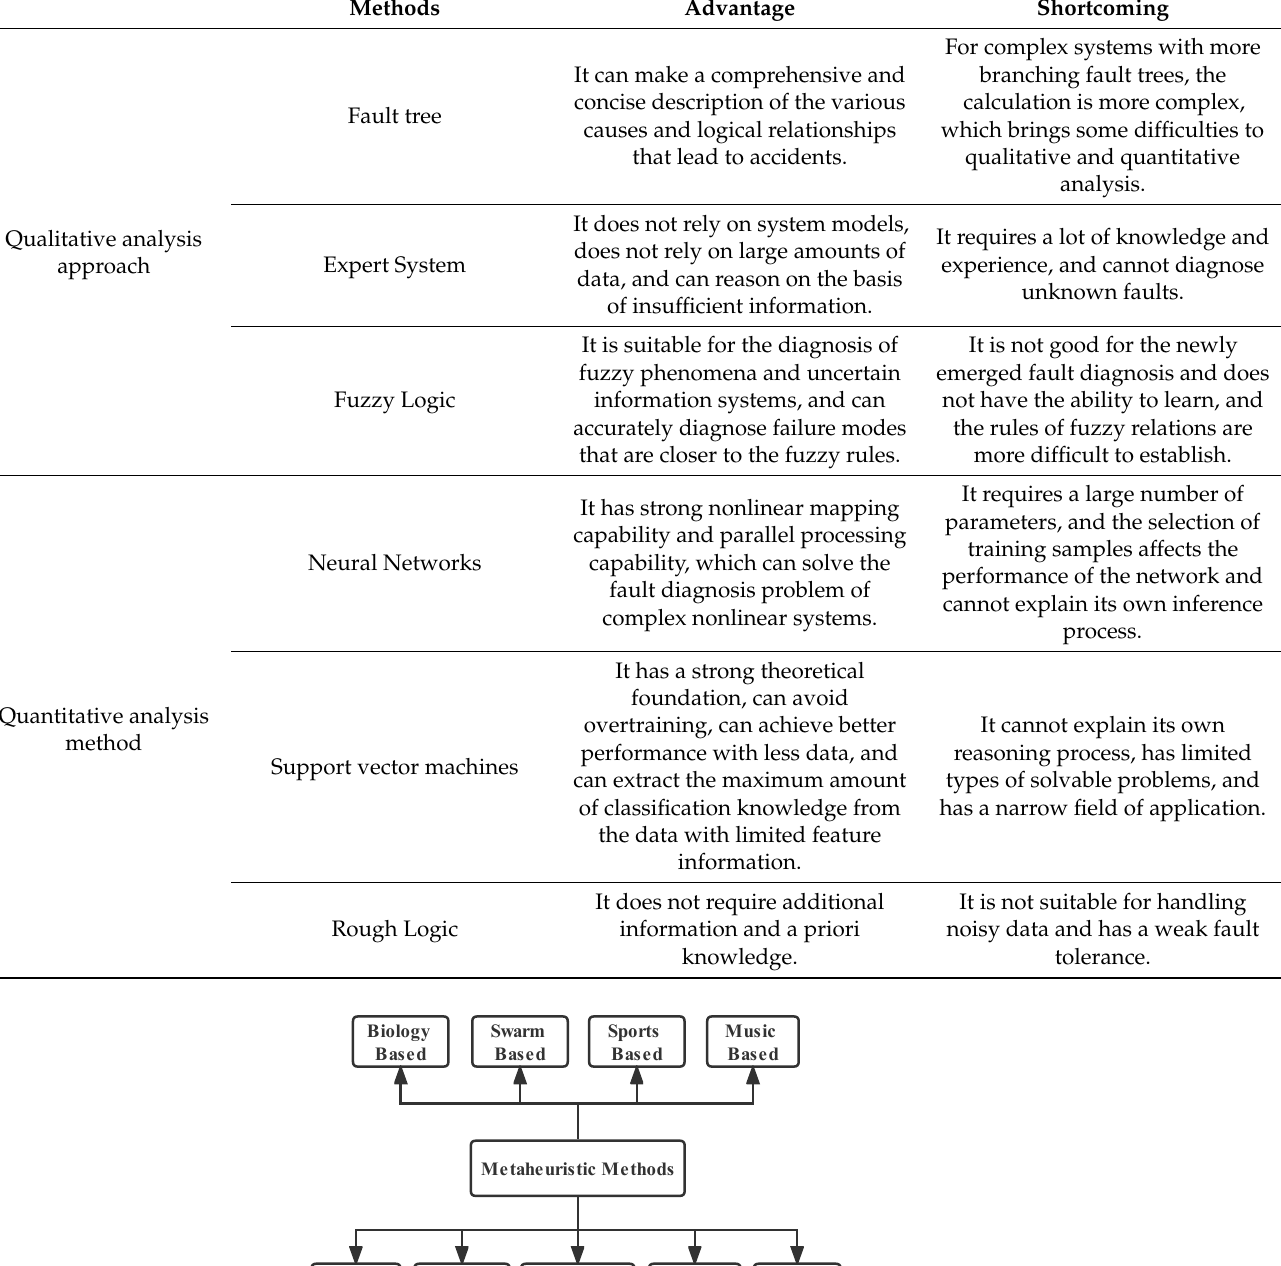
Table 1. Comparison of various methods.